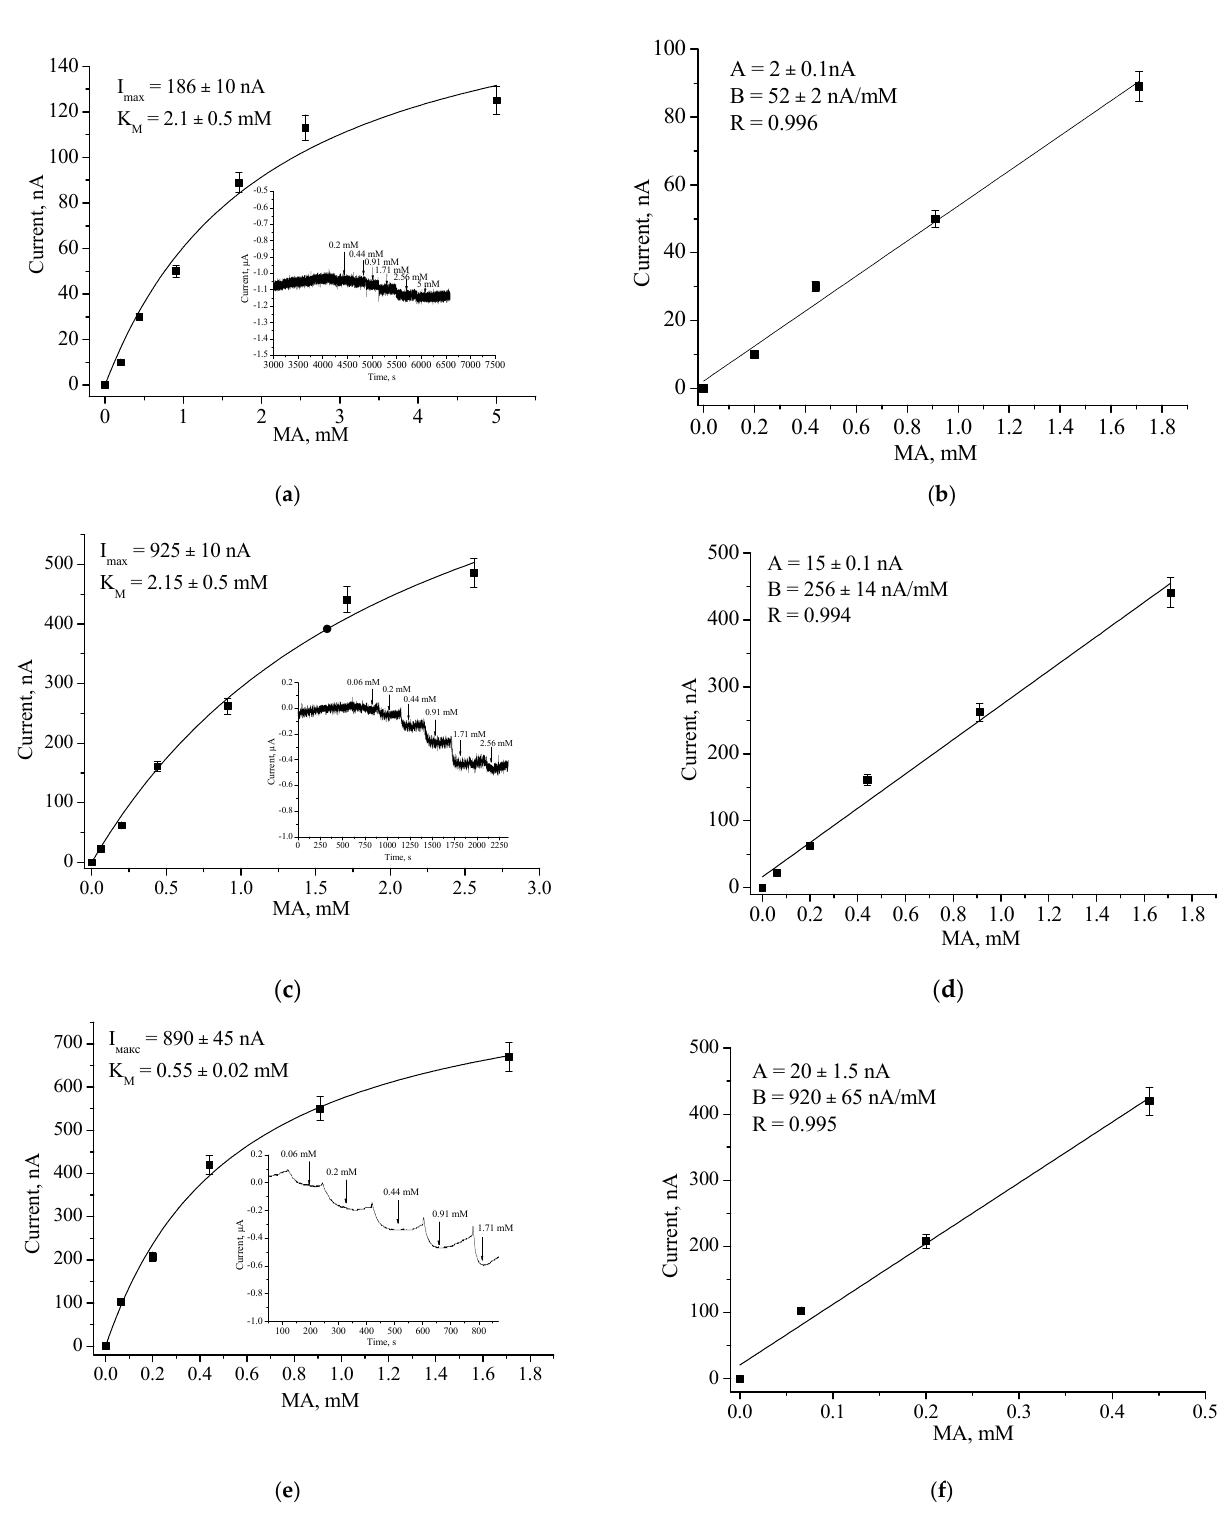
Figure 5. Amperometric characteristics of the AMO/PO/GE ( a , b ), the AMO/nCuCe/GE ( c , d ), and the AMO/nCuCe/npAu/GE ( e , f ): ( a , c , e ) chronoamperograms (inserted) and dependence of amperometric signal on concentration of MA; ( b , d , f ) calibration graphs for MA determination. Conditions: working potential –250 mV vs. Ag/AgCl/3 M KCl in 50 mM PB, pH 7.5.